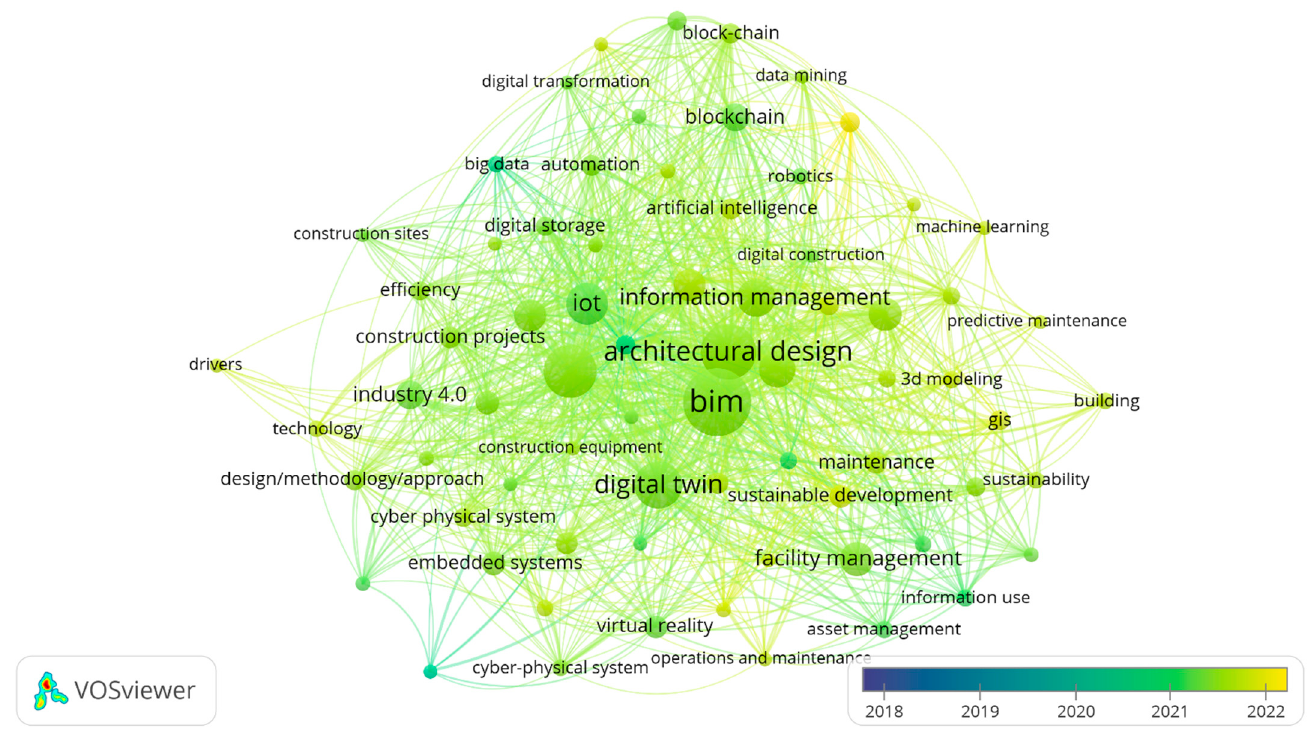
Figure 12. Co-occurrence network map temporal overlay performed with VOSviewer.